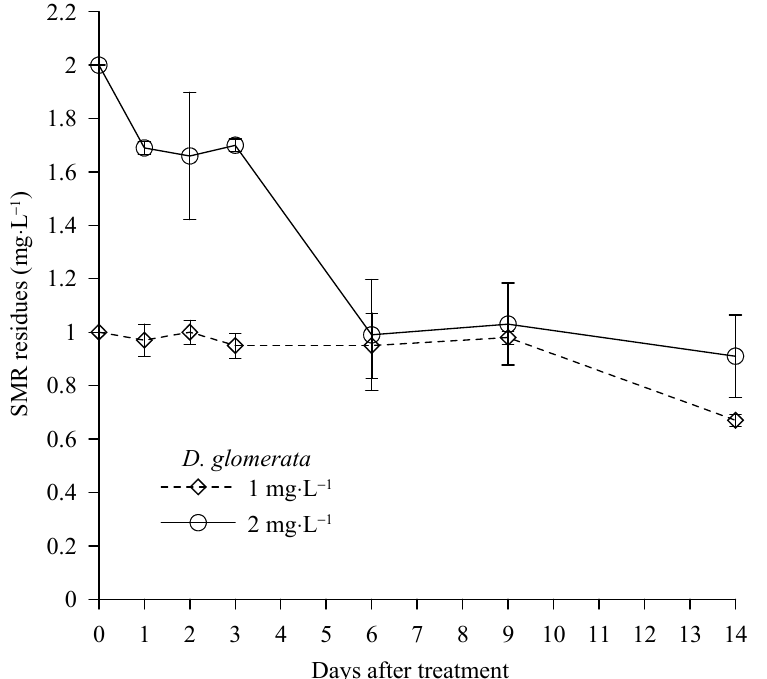
Figure 5. S-metolachlor (SMR) residues (mg L − 1 ) determined in the growth media of D. glomerata (orchardgrass) at 1, 2, 3, 6, 9, 14 days after treatments (DAT) with 1 and 2 mg L − 1 SMR concentrations. Vertical bars represent ± confidence intervals ( p = 0.05, n = 9).